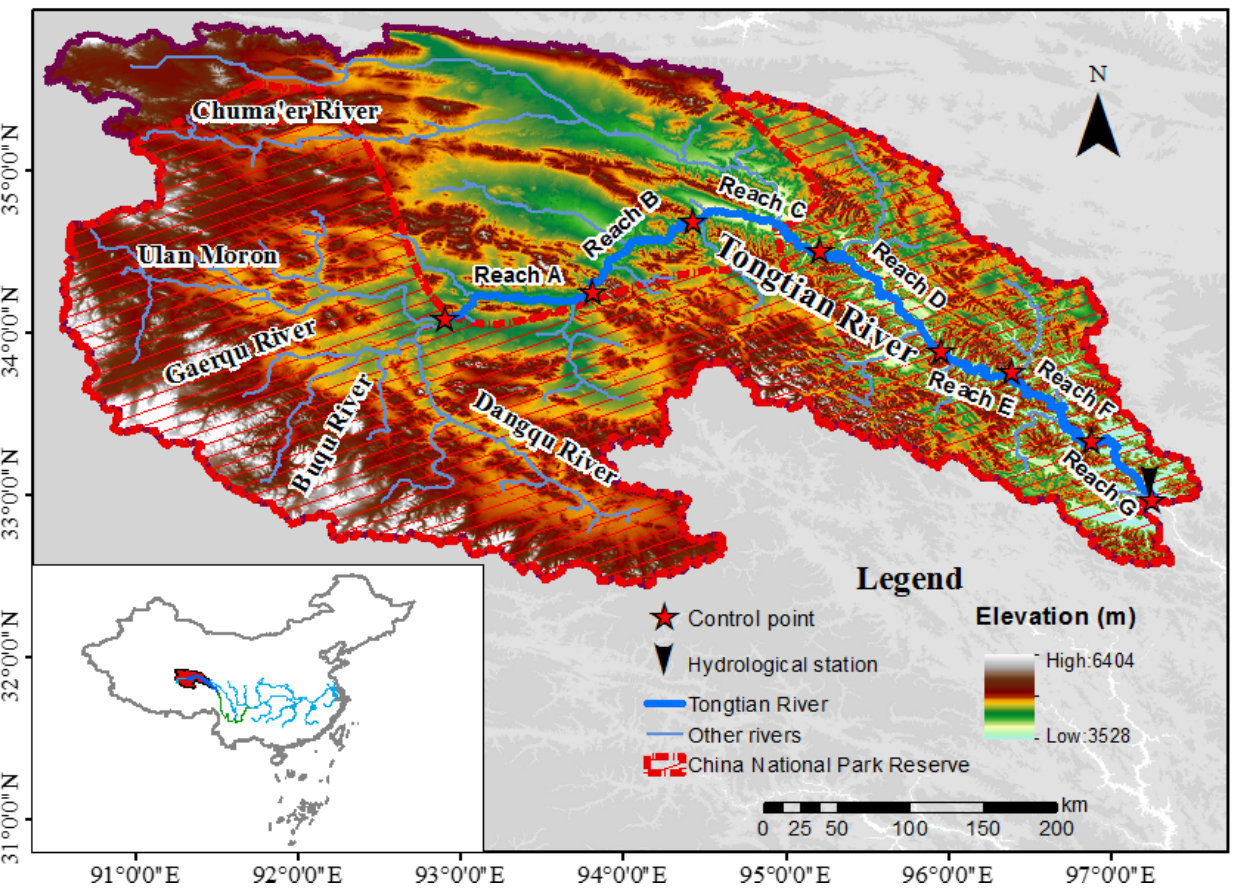
Figure 1. Overview of the study area, the Tongtian River Basin at the source of the Yangtze River. The red pentagrams represent the eight control points selected in this study. The black inverted triangle at the outlet of the lower Tongtian River is Zhimenda Hydrological Station. The inserted map on the lower-left corner shows the location of the Tongtian River in China and the major rivers of the Yangtze